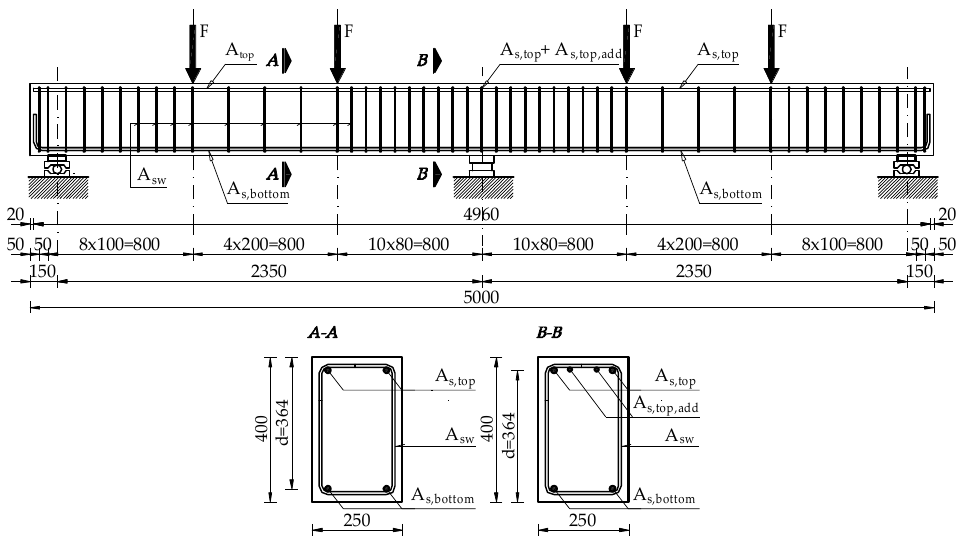
Figure 2. Details of specimen geometry and arrangement of reinforcement. Note: all dimensions are in mm.